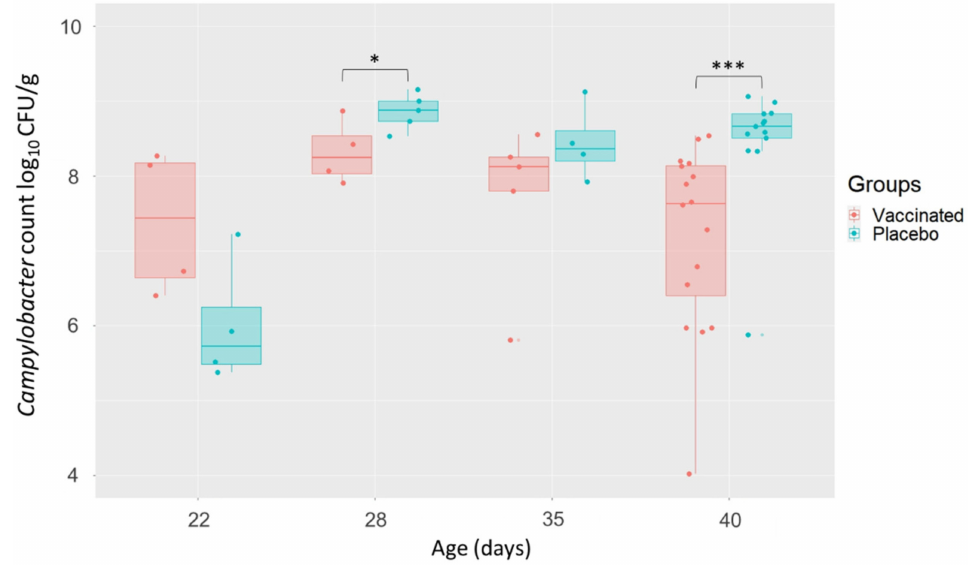
Figure 2. Effect of vaccination on Campylobacter colonisation of chicken caeca according to the age of the chickens (corresponding to the experiment days). Significant differences between the two groups are indicated by asterisks (* p < 0.05, *** p < 0.001; Wilcoxon rank sum